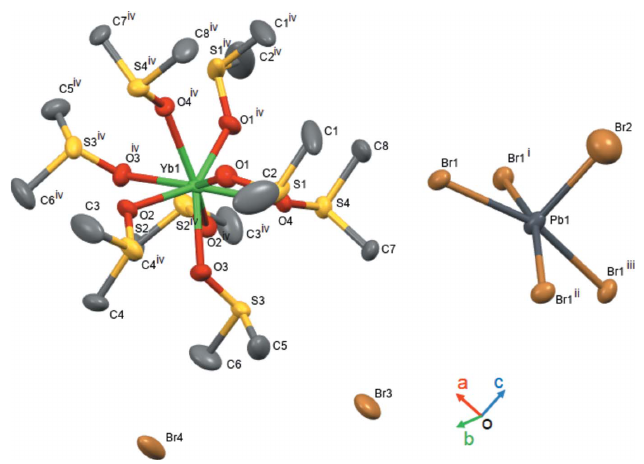
Figure 1 Arrangement of [Yb(DMSO) 8 ] 3+ , [PbBr 3 ] 2 (cid:3) and free Br (cid:3) anions in the precursor crystal, with displacement ellipsoids at the 50% probability level. The disordered DMSO molecule is omitted for clarity. Symmetry (cid:3) x , z ; (ii) 1 (cid:3) y , x , z ; (iii) 1 (cid:3) x , 1 (cid:3) y , z ; (iv) 3 (cid:3) x , 1 (cid:3) y , z codes: (i) y , 1 2 2 2 2 2 2